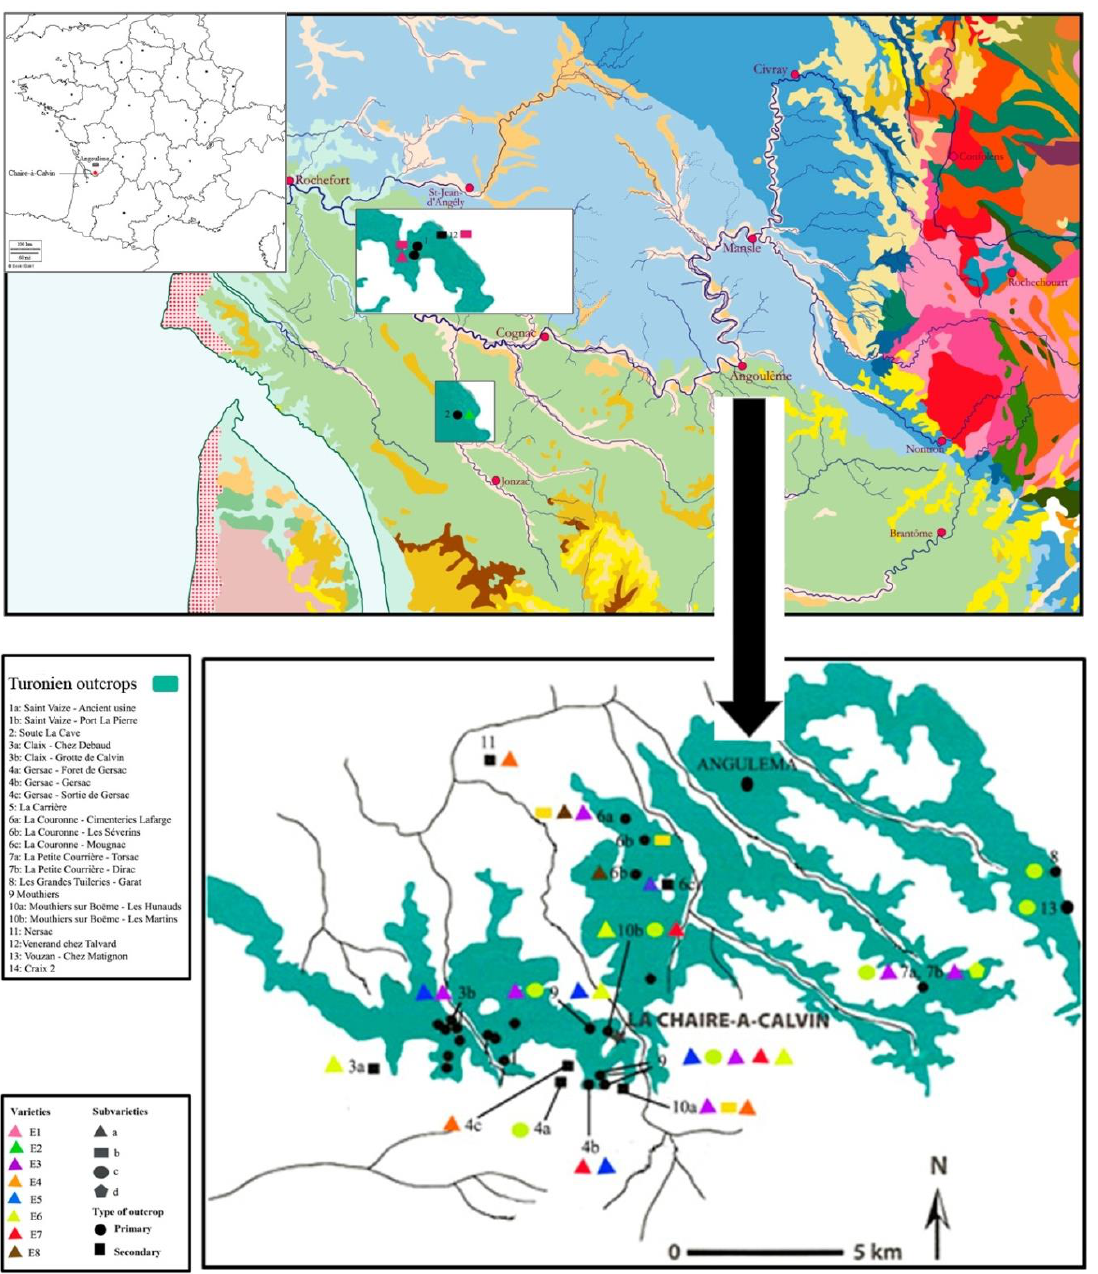
Figure7. Location map of the Turonian varieties of chert from Charente’s basin. Modified from Delage (2006) and Féblot Augustins & Monthel